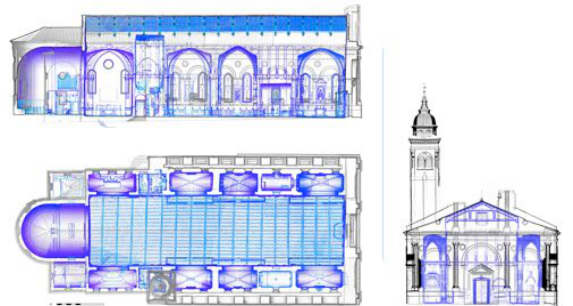
Figure 8: Comparative graphical analysis between the original framework of San Francesco church (blue point cloud) and the new rhythm given by the Albertian envelope (black point